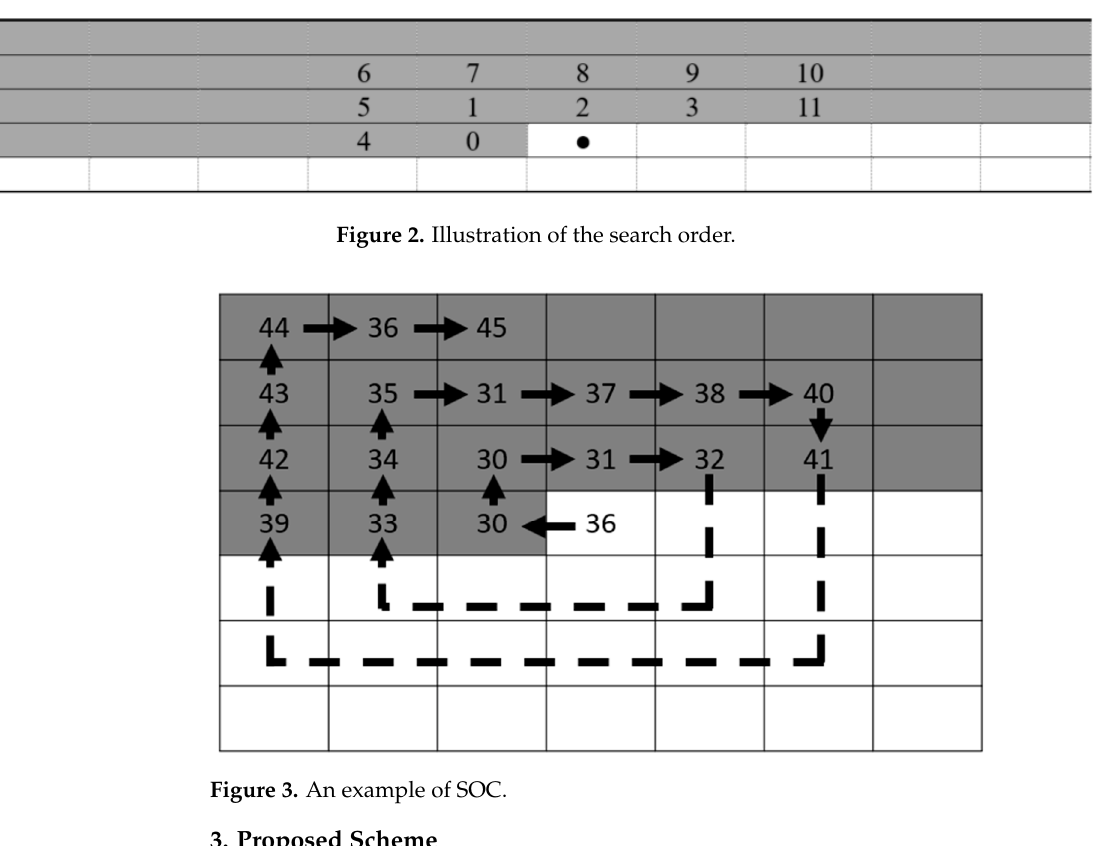
Figure 4. The flowchart of the proposed scheme.